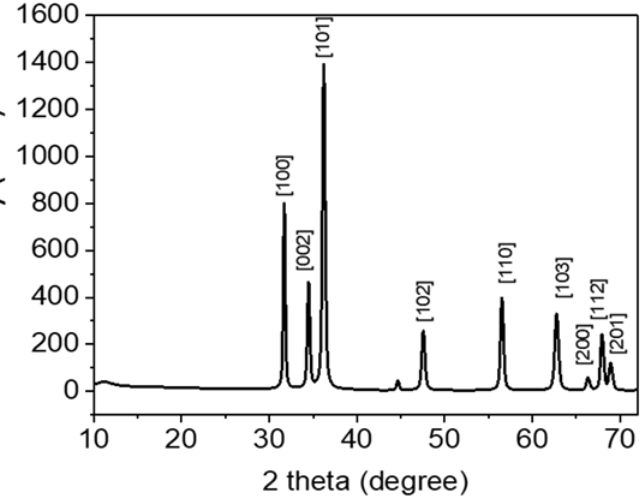
Figure 3. XRD pattern of ZnO nanorods synthesized by hydrothermal treatment showing nine peaks at 31.7°, 34.4°, 36.3°, 47.5°, 56.6°, 62.3°, 66.5°, 67.9°, and 69.1°.